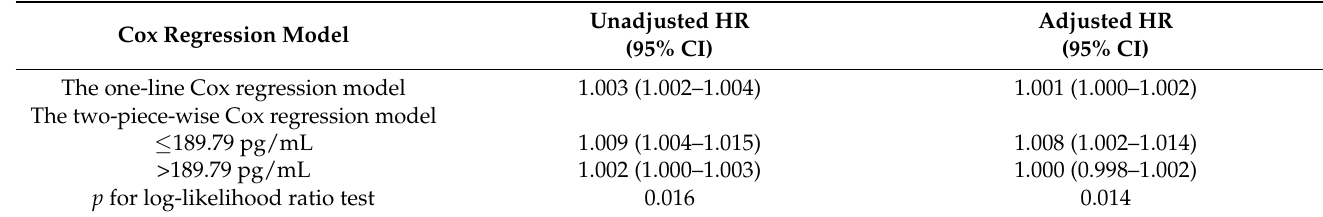
Figure 4. Three-knot restricted cubic splines of the relationship between the baseline VEGF and risk of death. The restricted cubic spline of VEGF ( A ) before and ( B ) after adjustment for confounders. Table 3. Threshold effect analysis for the baseline serum VEGF based on a two-piece-wise Cox regression